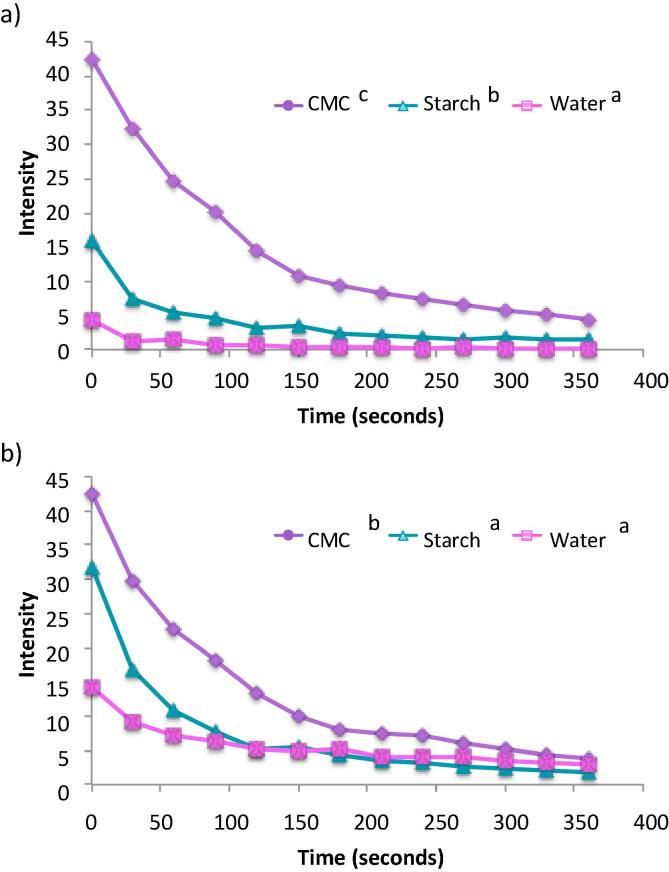
Progressive profiling data for a) adhesion and b) mouthcoating. Each data point represents the mean for the 11 panellists and their duplicate tests. Error bars are not included in this graph as there is large individual variation in scores over the time period. The letters next to the sample key represent statistically significant groupings. Different letters represents a significant difference of p < 0.05.